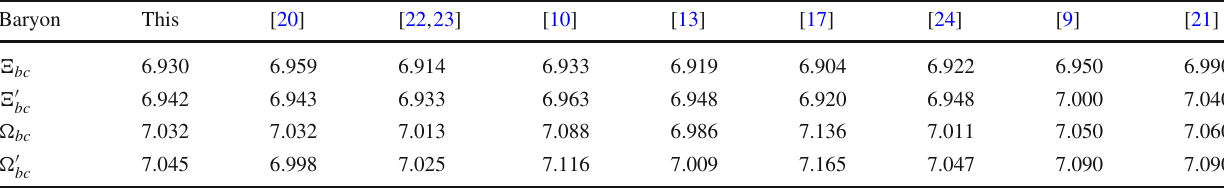
Fig. 7 BS radial wave functions of the J P = 1 Table 2 Comparisons of the mass predictions for the 1 ( bc ) -diquark cores, and the primed ones correspond to those with 0 + ( bc ) -diquark